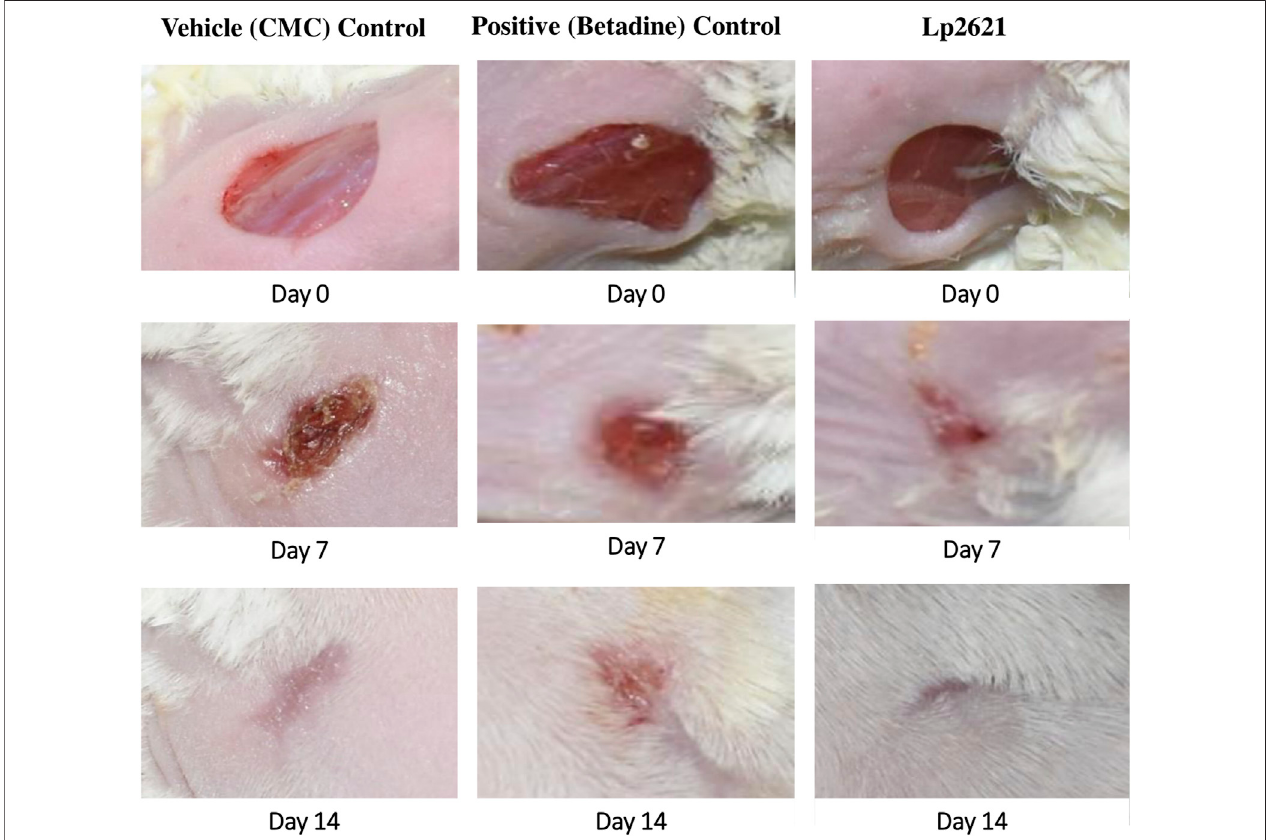
FIGURE 10 | Full-thickness excision wounds were created in mice and infected with S. aureus . Representative photographs from mice showing macroscopic wound closure on different day ’ s post-injury.